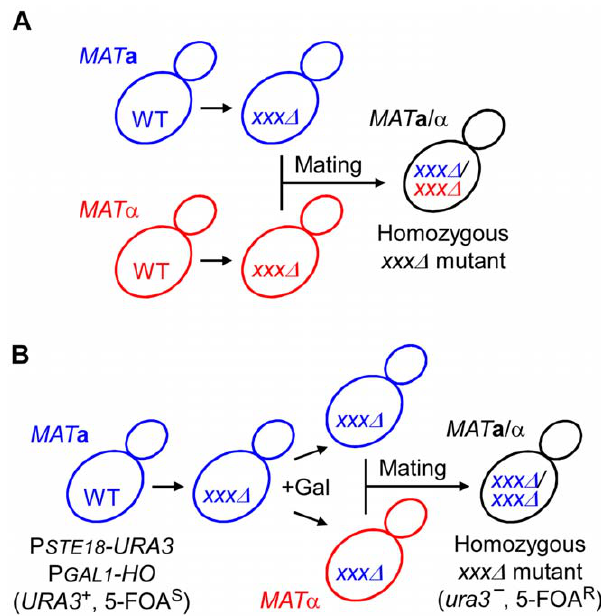
Figure 1. Strategy for construction of homozygous diploid strains. (A) The traditional method requires individual construction of MAT a and MAT a haploid strains carrying different selection markers (linked to mutations or each strain). The diploid strains can be selected on plates lacking nutrients or containing antibiotics. (B) The new method proposed in this study generates homozygous diploids from a single haploid strain by subsequent use of the PGAL1-HO (galactose- inducible mating-type switch) and PSTE18-URA3 (counter selection marker for diploids) genes. The diploid strains are selected on plates containing 5-FOA, where non-mated haploid strains cannot grow.